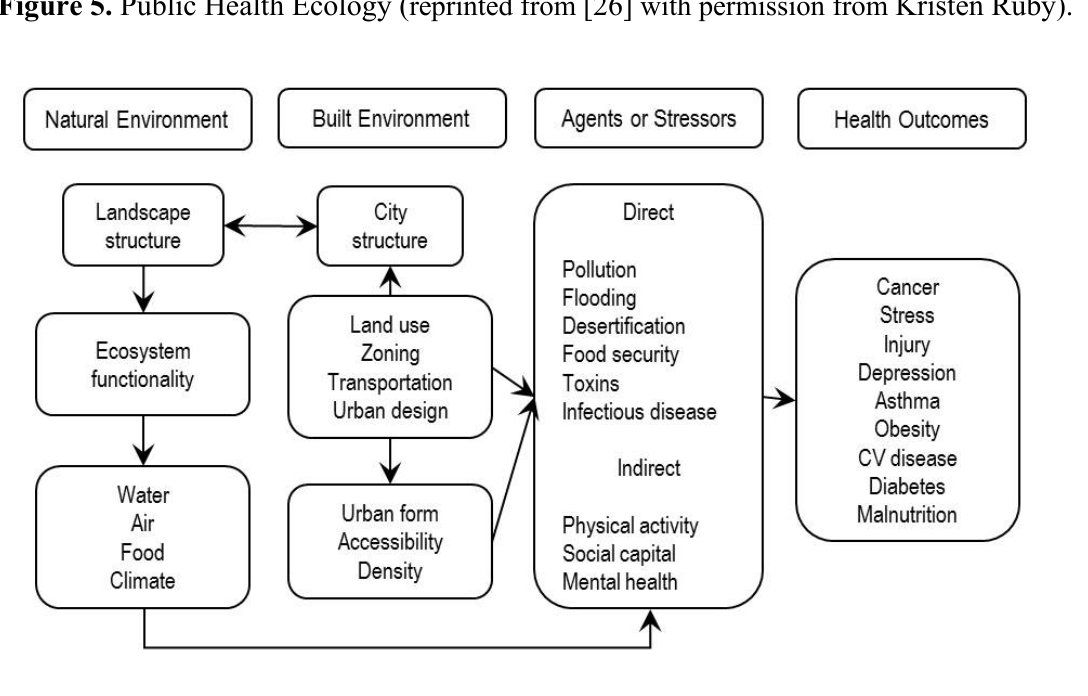
Figure 5. Public Health Ecology ( reprinted from [26] with permission from Kristen Ruby )